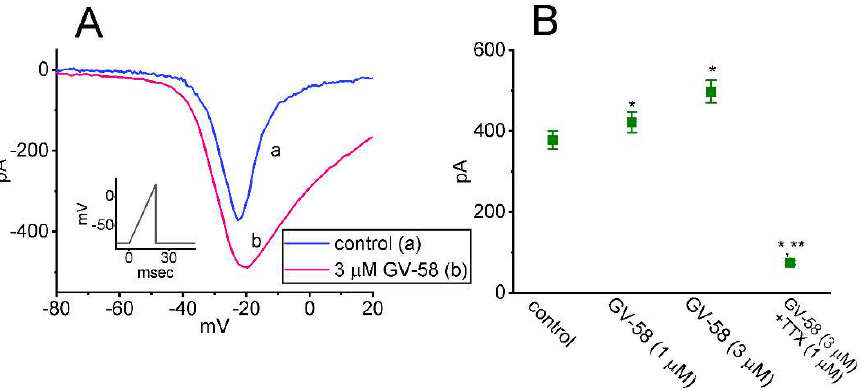
Figure 8. Stimulatory effect of GV − 58 on window I Na ( I Na(W) ) activated in response to the upsloping ramp pulse in GH 3 cells. In these experiments, the examined cell was held at −80 mV, and we applied the ascending ramp pulse from −80- to +20 mV with a duration of 20 ms (5 mV/ms) to it. ( A ) Representative current traces activated by ramp pulse with a duration of 30 ms during the control period (a) and in the presence of 3 μM GV − 58 (b). Inset in ( A ) indicates the voltage − clamp protocol applied. ( B ) Summary graph showing effect of GV − 58 and GV − 58 plus tetrodotoxin (TTX) on I Na(W) amplitude identified in GH 3 cells (mean ± SEM; n = 8 for each bar). Current amplitudes measured at the level of −20 mV were taken. * Significantly different from control ( p < 0.05) and ** significantly different from GV − 58 (3 μM) alone group ( p < 0.05). Statistical analyses were made by one − way